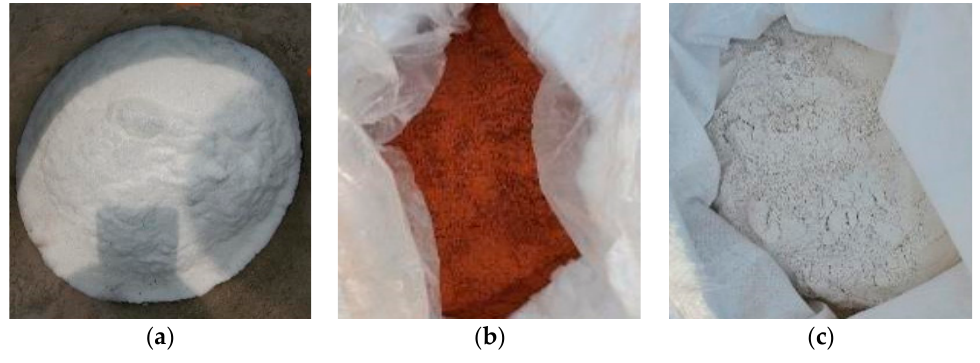
Figure 2. Types of additives. ( a ) High-polymer. ( b ) Red mud. ( c ) Metakaolin.